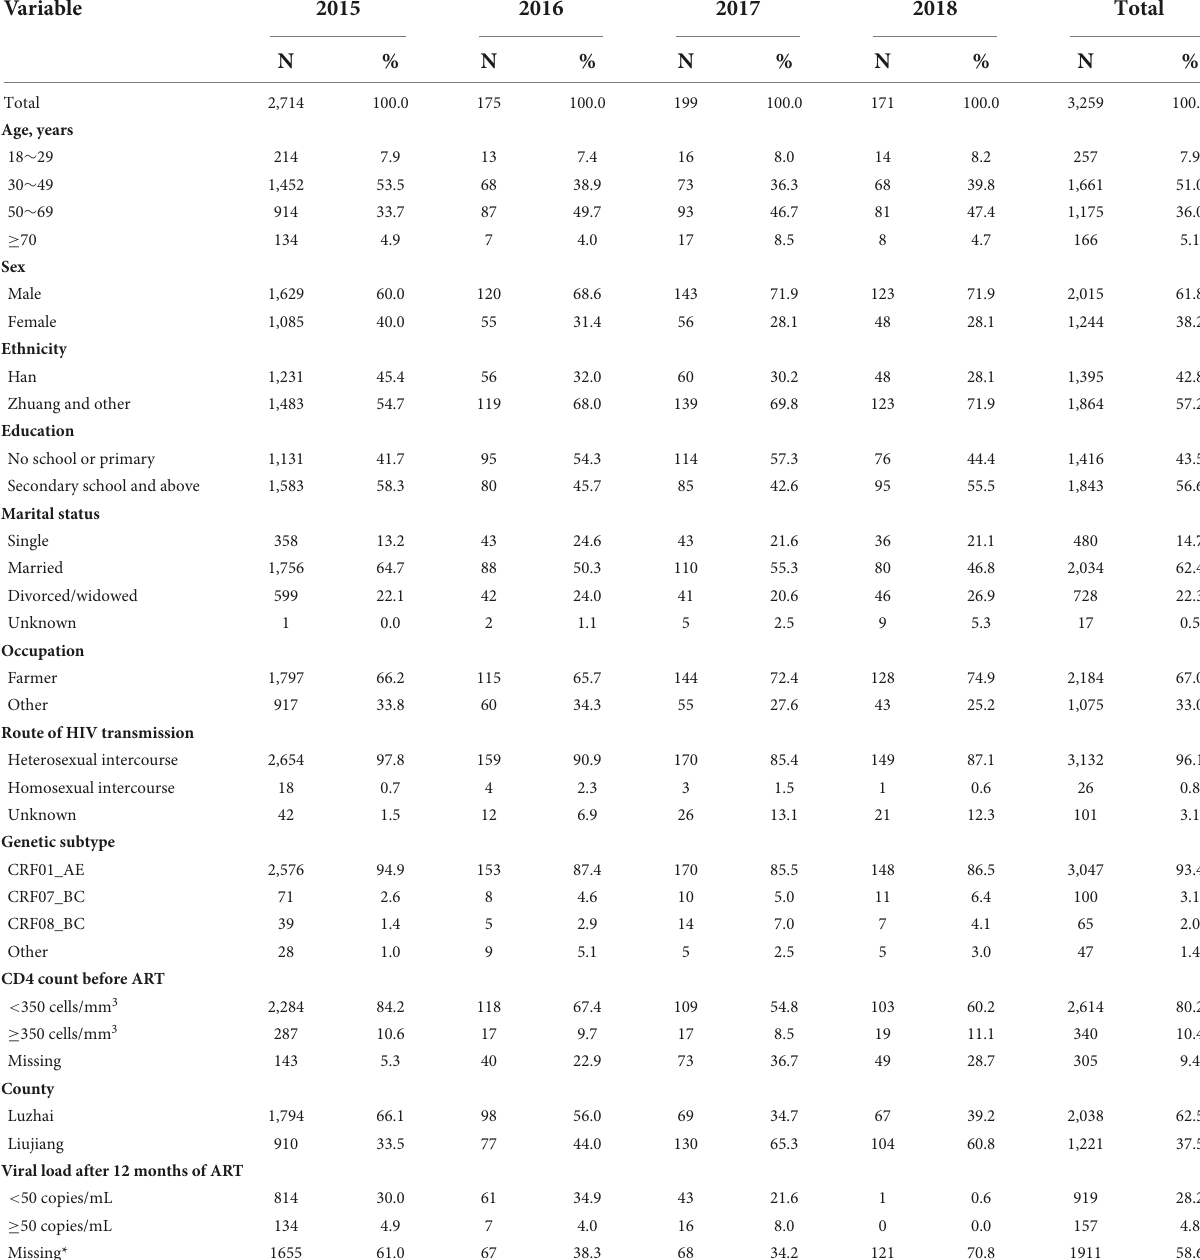
TABLE 1 General characteristics of patients with HIV between 2015 and 2018 in Guangxi of